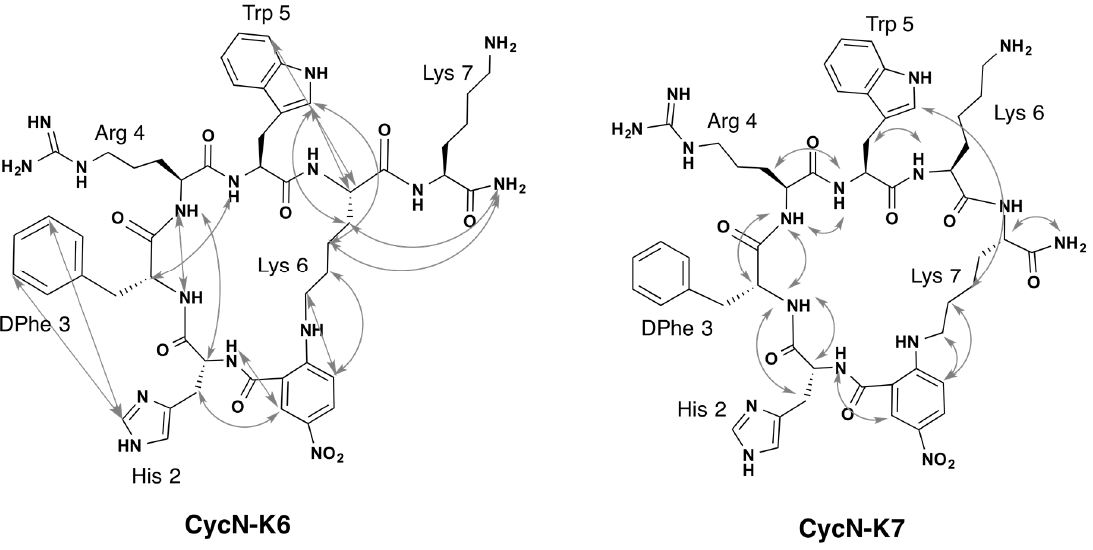
Figure 2. Relevant NOEs observed for peptides CycN-K6 and CycN-K7 in aqueous solution. The double arrows connect the protons for which NOE cross-peaks are observed in the 1 H, 1 H-ROESY spectra.